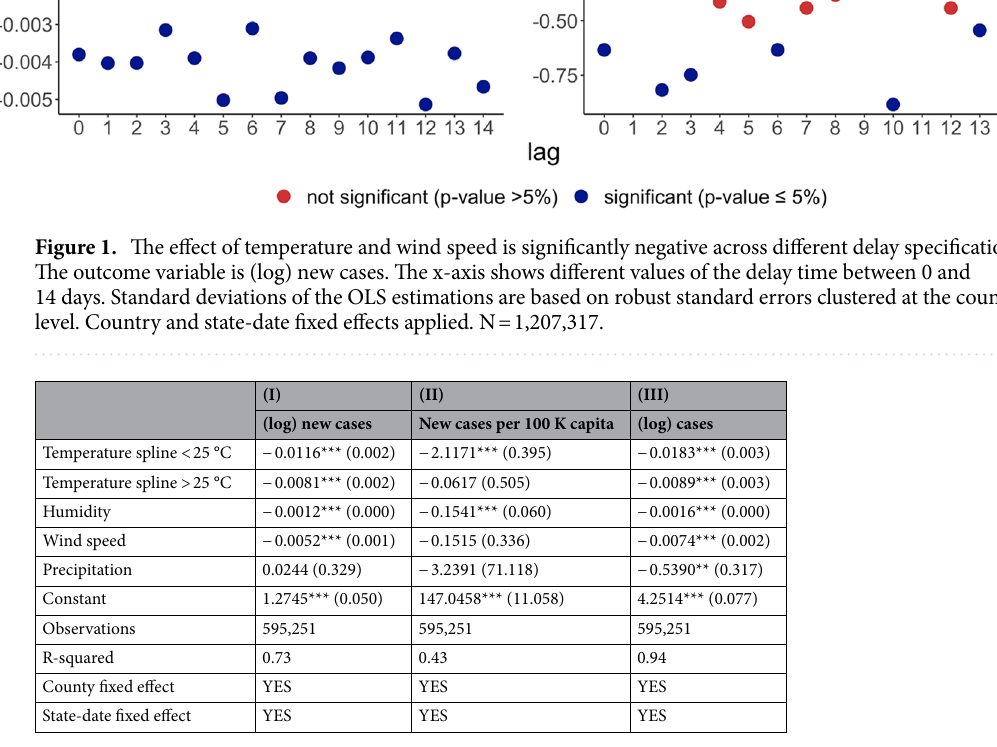
Table 2. The non-linear effect of different weather indicators at t-7 (at 12:00 local time) on different pandemic indicators. The outcome variables are (log) new cases (I), the number of new cases per 100,000 habitants within the last 14 days (II) and (log) cases (III). Standard deviations based on robust standard errors clustered at the county level in parentheses. ***,**,*Significance at 1, 5 and 10%, respectively; N =